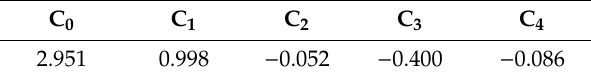
Figure 3. Fitted curve of open-circuit voltage-state of charge (OCV-SOC). Table 3. Fitted parameters for the OCV-SOC curve.